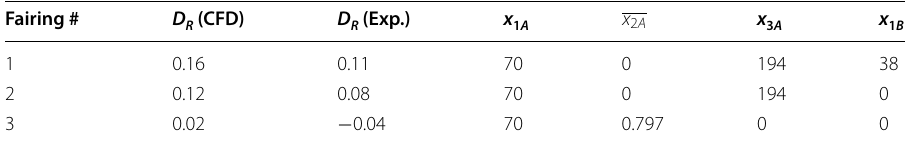
Table 1 Drag reduction and design variable values for the five fairings tested in the wind tunnel. Dimensioned variables are given in cm Fairing